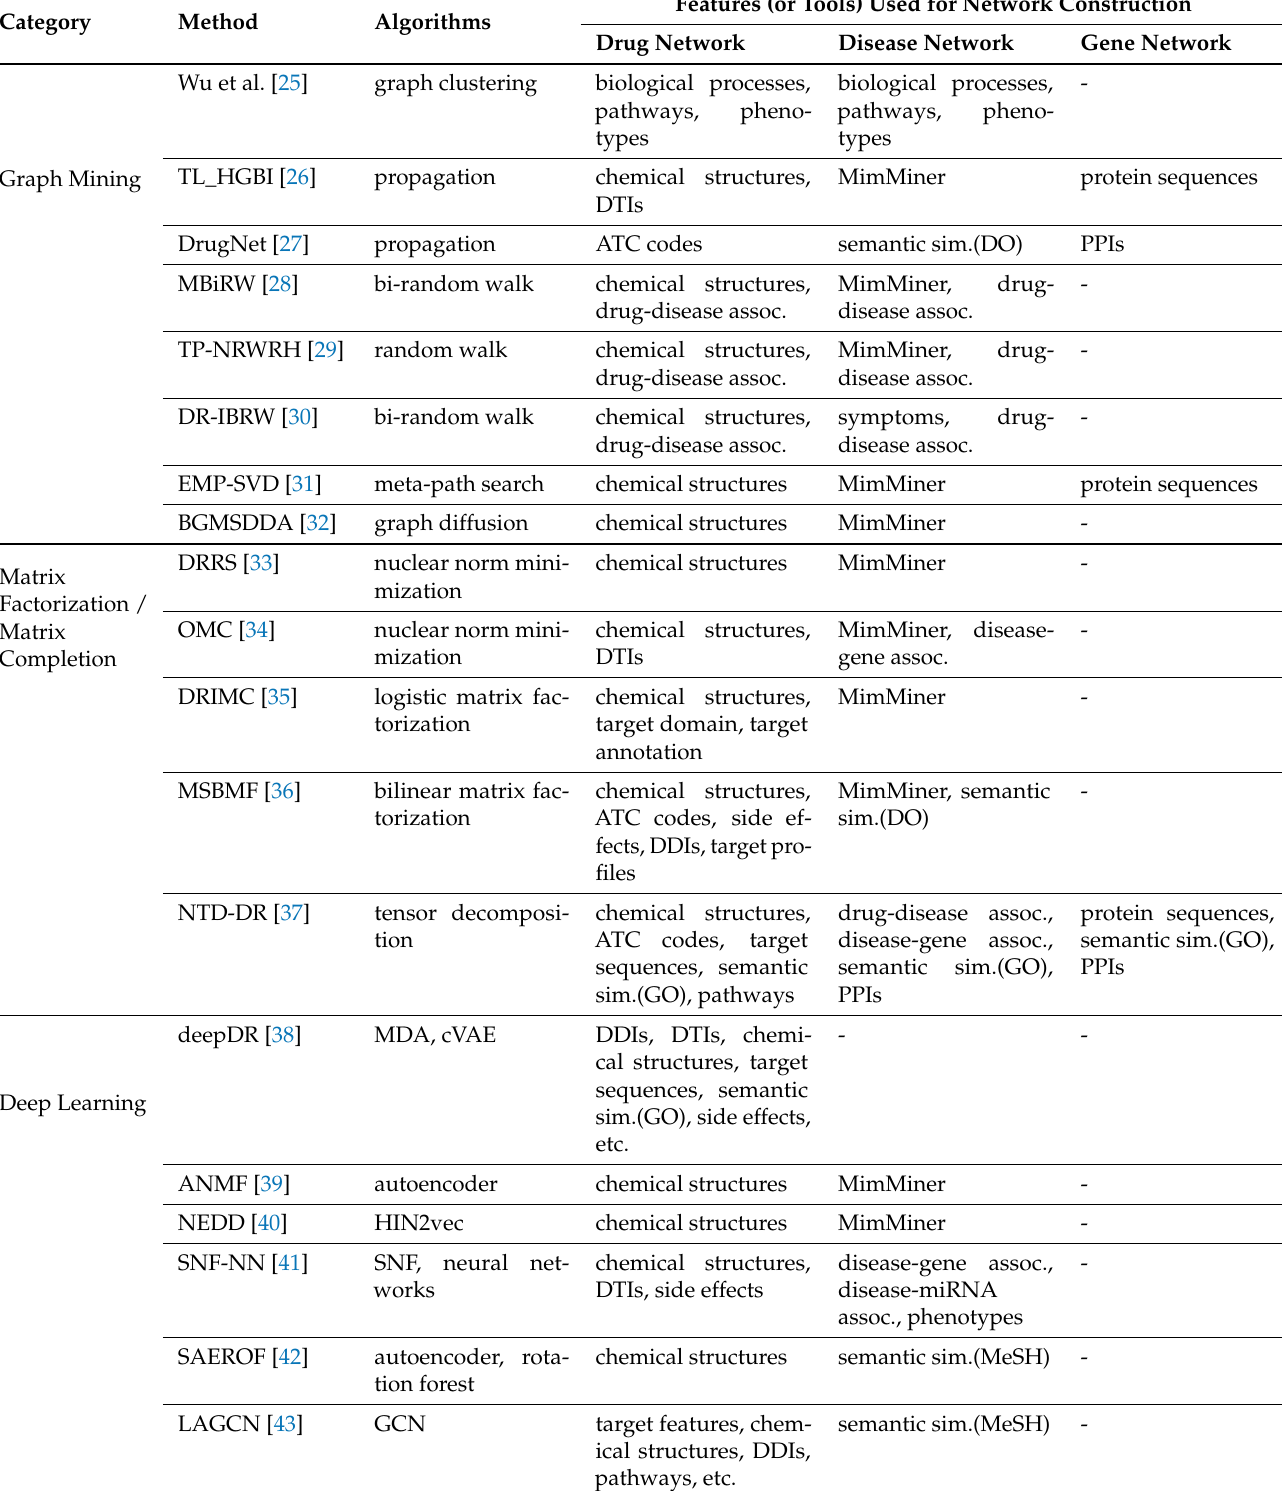
Table 1. List of network-based methods for predicting drug–disease associations in three categories. This list also shows the main algorithms and the features (or tools) to construct drug–drug, disease– disease, and gene–gene similarity networks for each